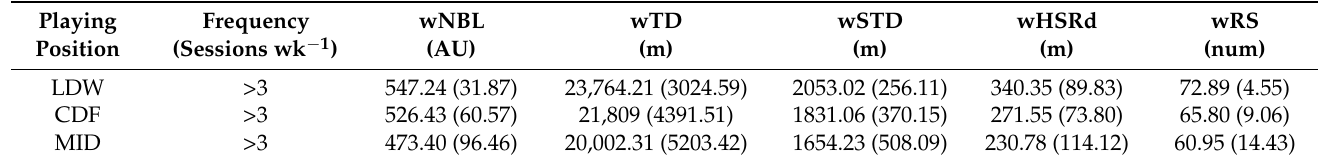
Table 1. Descriptive data of weekly average for all derived GPS variables by playing